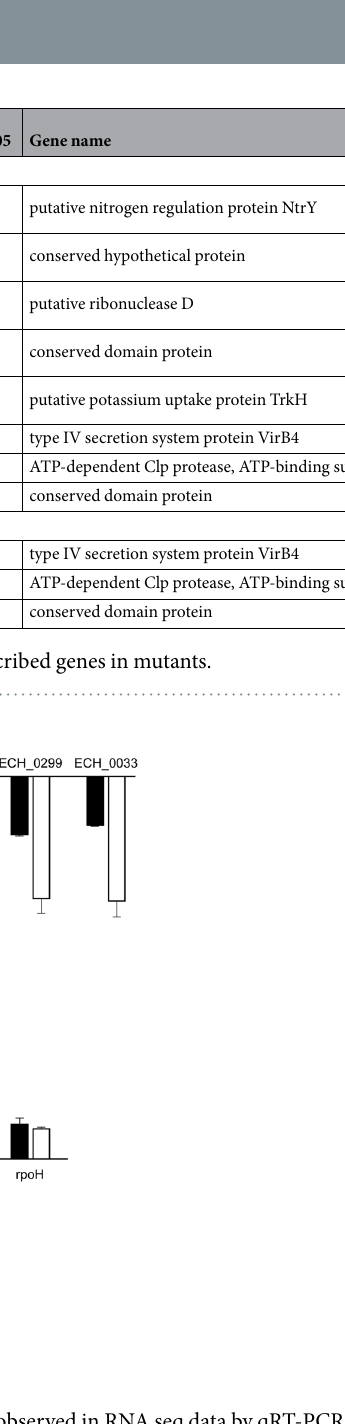
Figure 3. Verification of transcriptional variations observed in RNA seq data by qRT-PCR. Transcriptional fold changes in wildtype vs. ECH_0379 mutant ( A ), ECH_0490 mutant ( B ), or ECH_0660 mutant ( C ) were presented from the qRT-PCR data. Black bars represents RNA seq data and white bars represents qRT-PCR